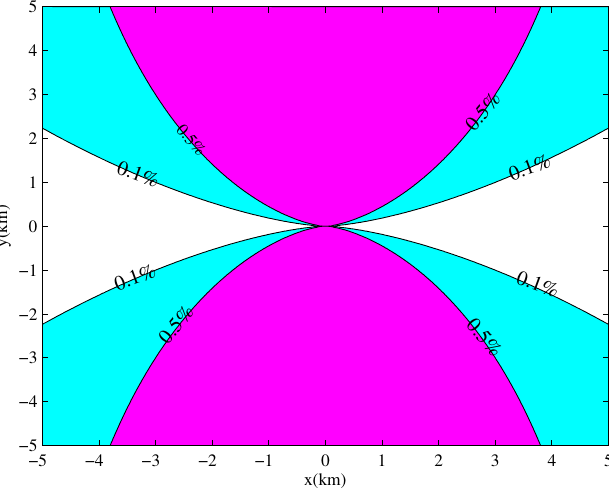
Figure 4. The filled contour plot of the Doppler frequency shift variance with motion type